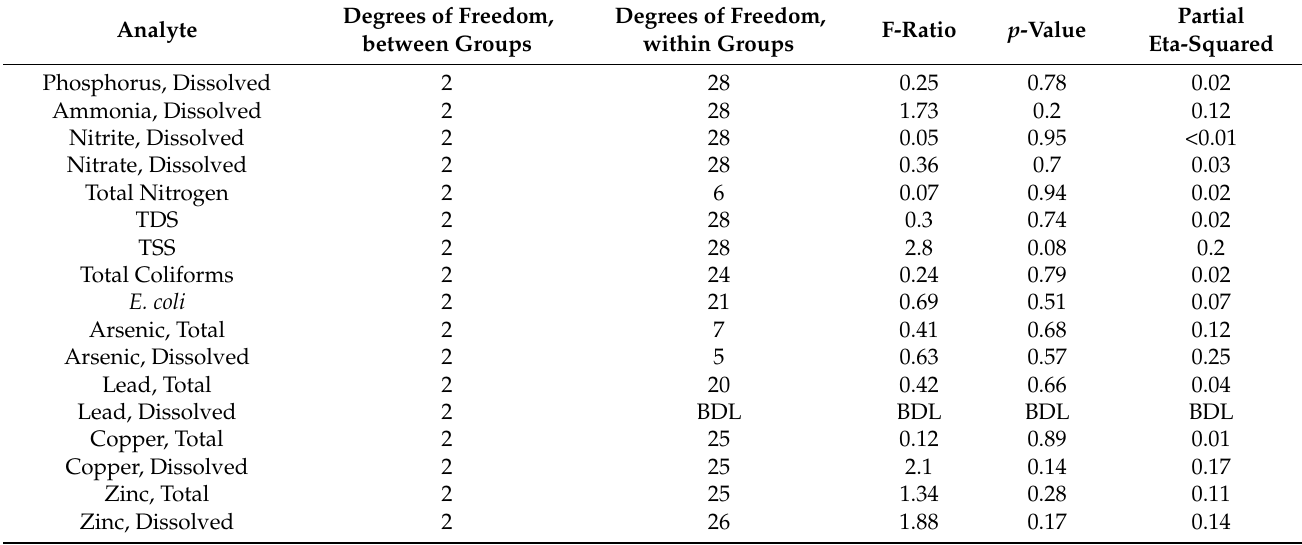
Table A3. ANCOVA results with rainfall intensity as the confounding